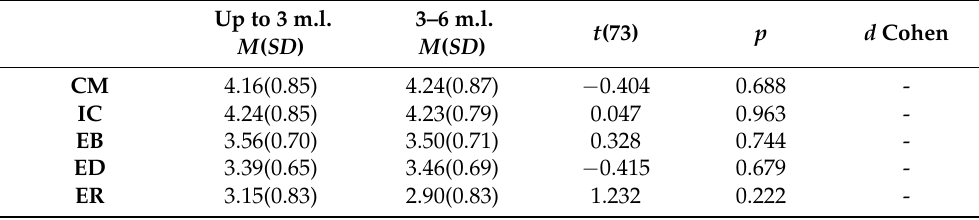
Table 11. The differences in identity among first-time fathers taking into consideration the age of